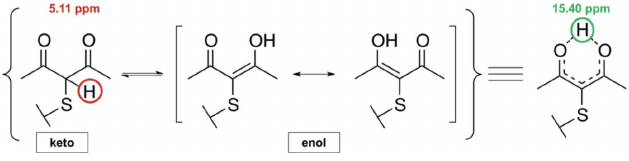
Figure 5 Tautomeric effect observed in the acetylacetonate portion of the title compound.